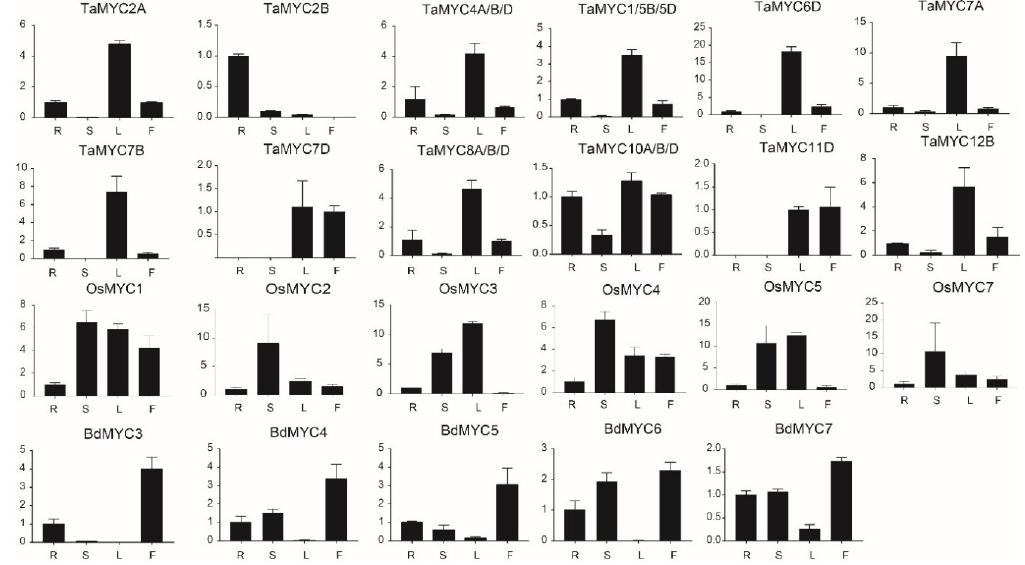
Figure 6. Expression patterns of TaMYC , OsMYC , and BdMYC genes in different tissues. R, S, L, F indicate roots, stems, leaves, and inflorescences. The horizontal and vertical coordinates stand for four different tissues and the relative expression, respectively.